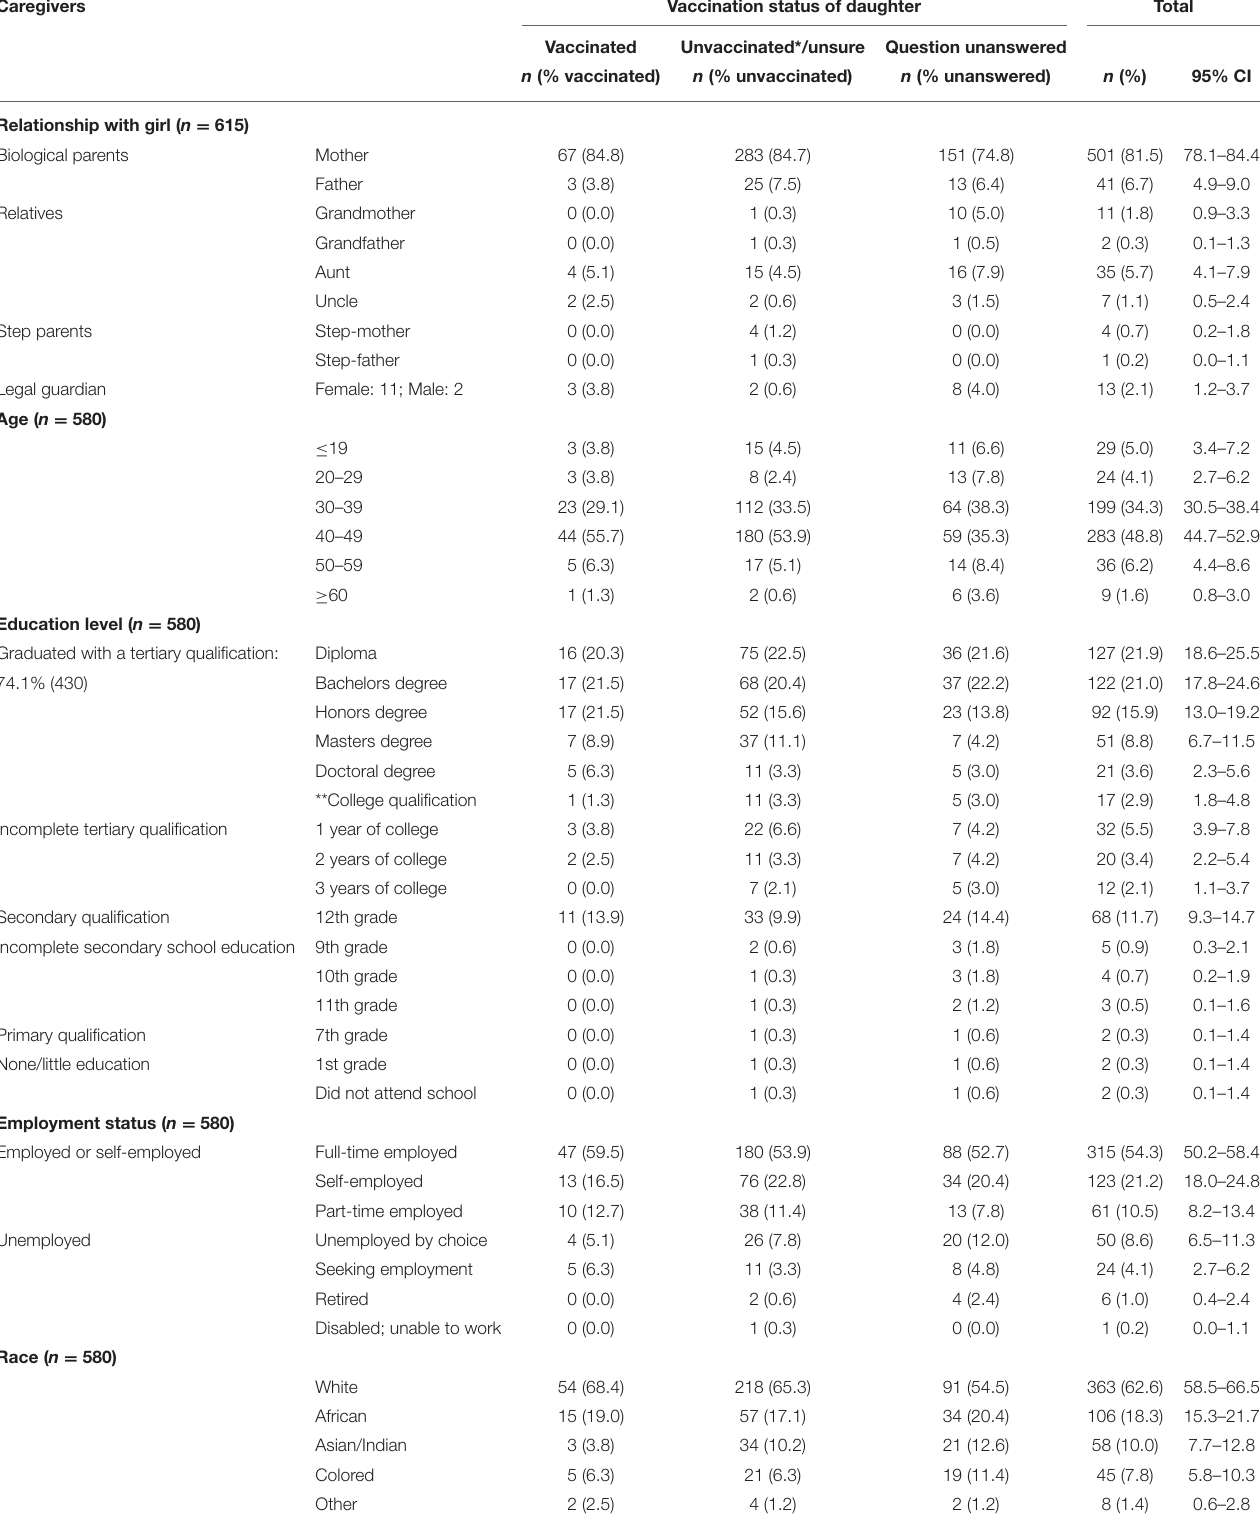
TABLE 2 | Frequency distributions of socio-demographics of caregivers, stratified by HPV vaccination status of daughters.